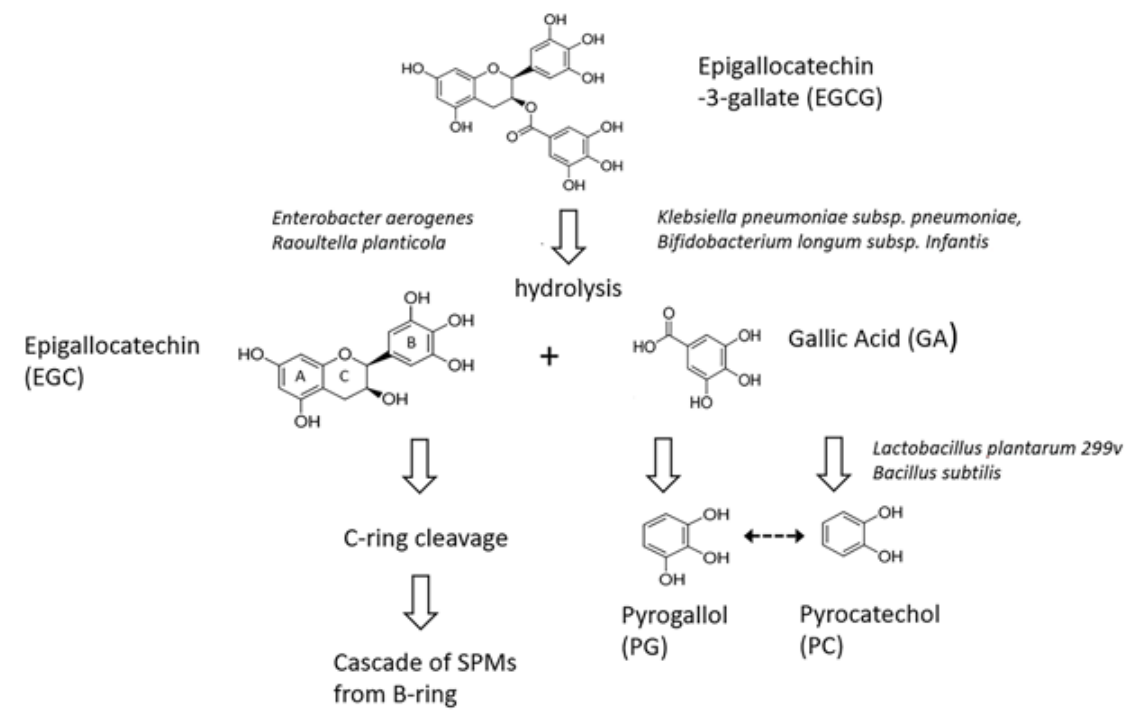
Figure 3. Possible metabolic pathways from (-)-epigallocatechin gallate to pyrogallol and pyrocatechol. Known bacterial constituents of the GMB mediating a given step are italicized. Possible interconversions of pyrogallol and pyrocatechol (dotted arrow) are less well characterized. SPMs: small phenolic